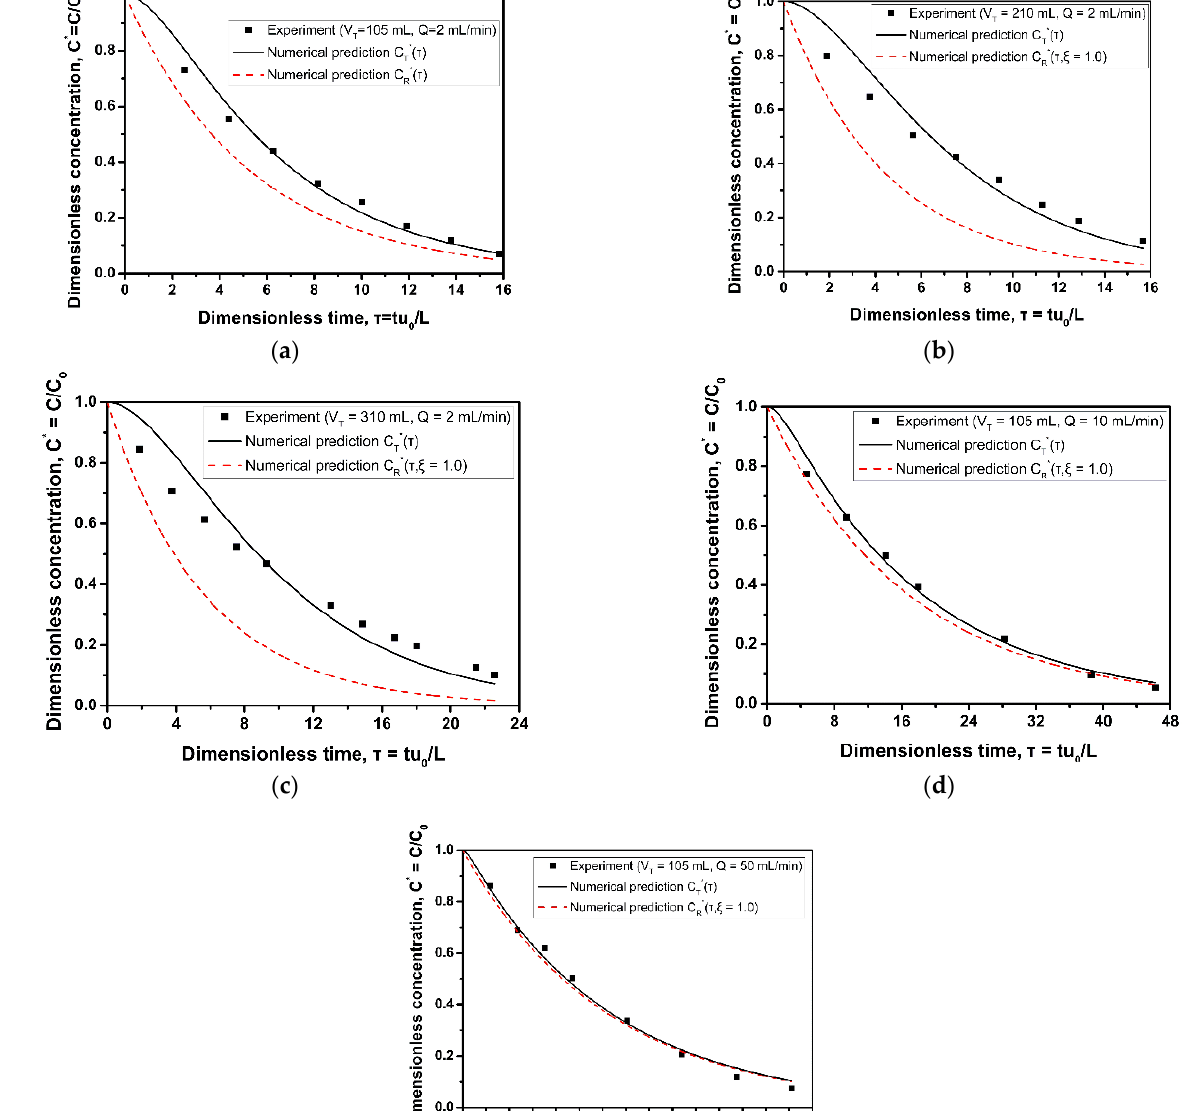
Figure A1. Comparison of numerical prediction with experimental measurements of the transient response of phenol concentration in continuous flow PMMA photoreactor for various values of the flow rate and liquid volume in recycle tank. ( a ) V T = 105 mL, Q = 2 mL/min; ( b ) V T = 210 mL, Q = 2 mL/min; ( c ) V T = 310 mL, Q = 2 mL/min; ( d ) V T = 105 mL, Q = 10 mL/min; ( e ) V T = 105 mL, Q = 50 mL/min.